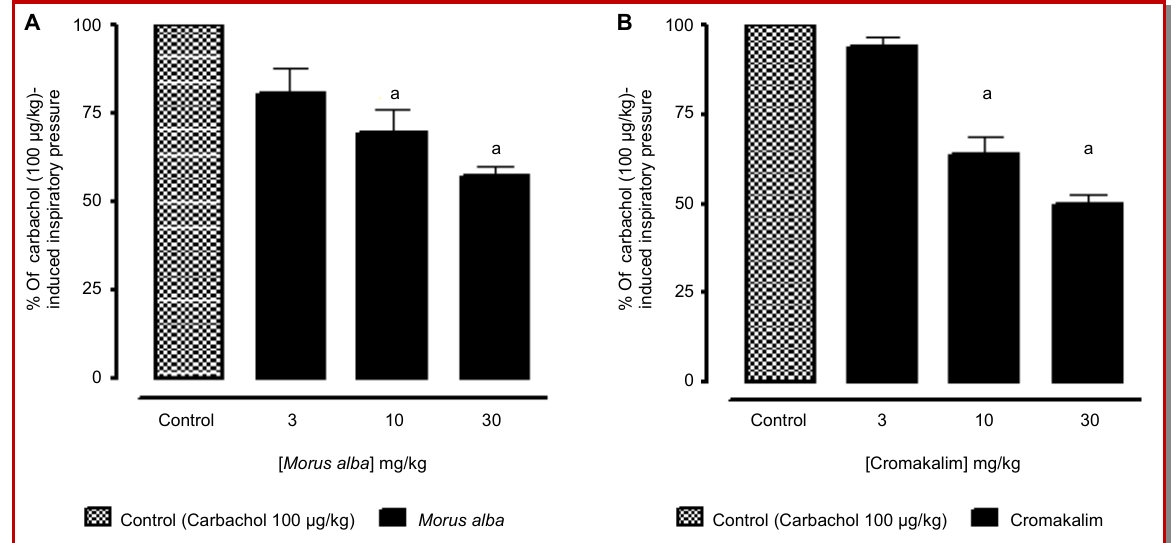
Figure 3: Dose-dependent suppressant effect of (A) crude extract of Morus alba and (B) cromakalim on carbachol-mediated bronchoconstriction in anaesthetized rats. Values shown are mean  SEM, n = 4-5, a p<0.01 vs. control (Carbachol), One-way analysis of variance, followed by Dunnett’s